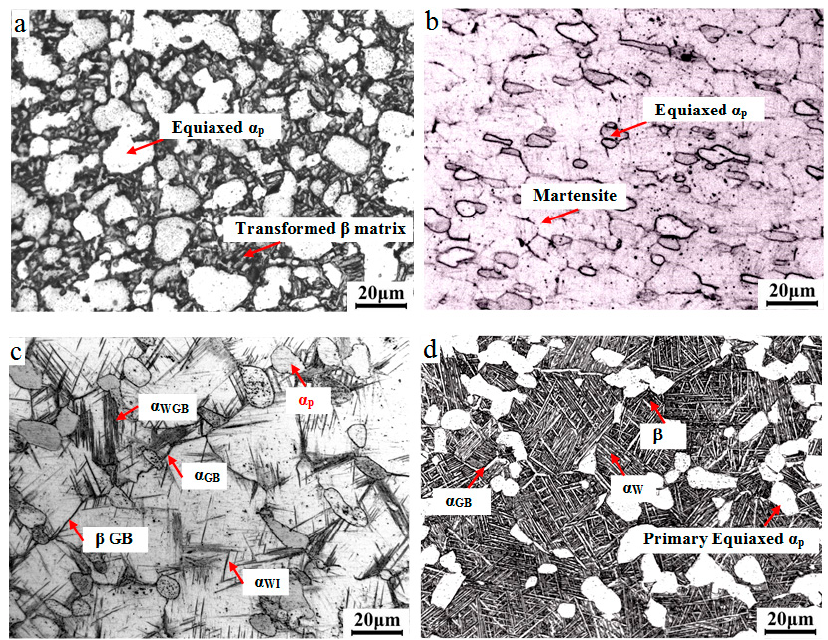
Figure 1. Optical micrographs of TA15 alloy after near- β forging: ( a ) Original optical micrograph of as received TA15; ( b ) 970 °C/0.1 s − 1 /65%/(WQ); ( c ) 970 °C/0.1 s − 1 /65%/(AC + WQ); ( d ) 970 °C/65%/0.1 s − 1 /(AC). WQ: water quenching, AC: air cooling.